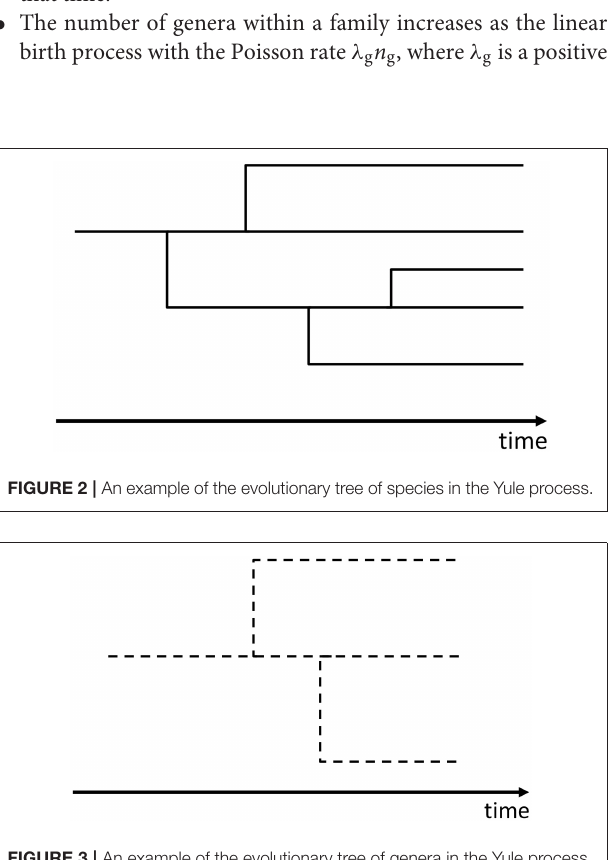
FIGURE 3 | An example of the evolutionary tree of genera in the Yule process.